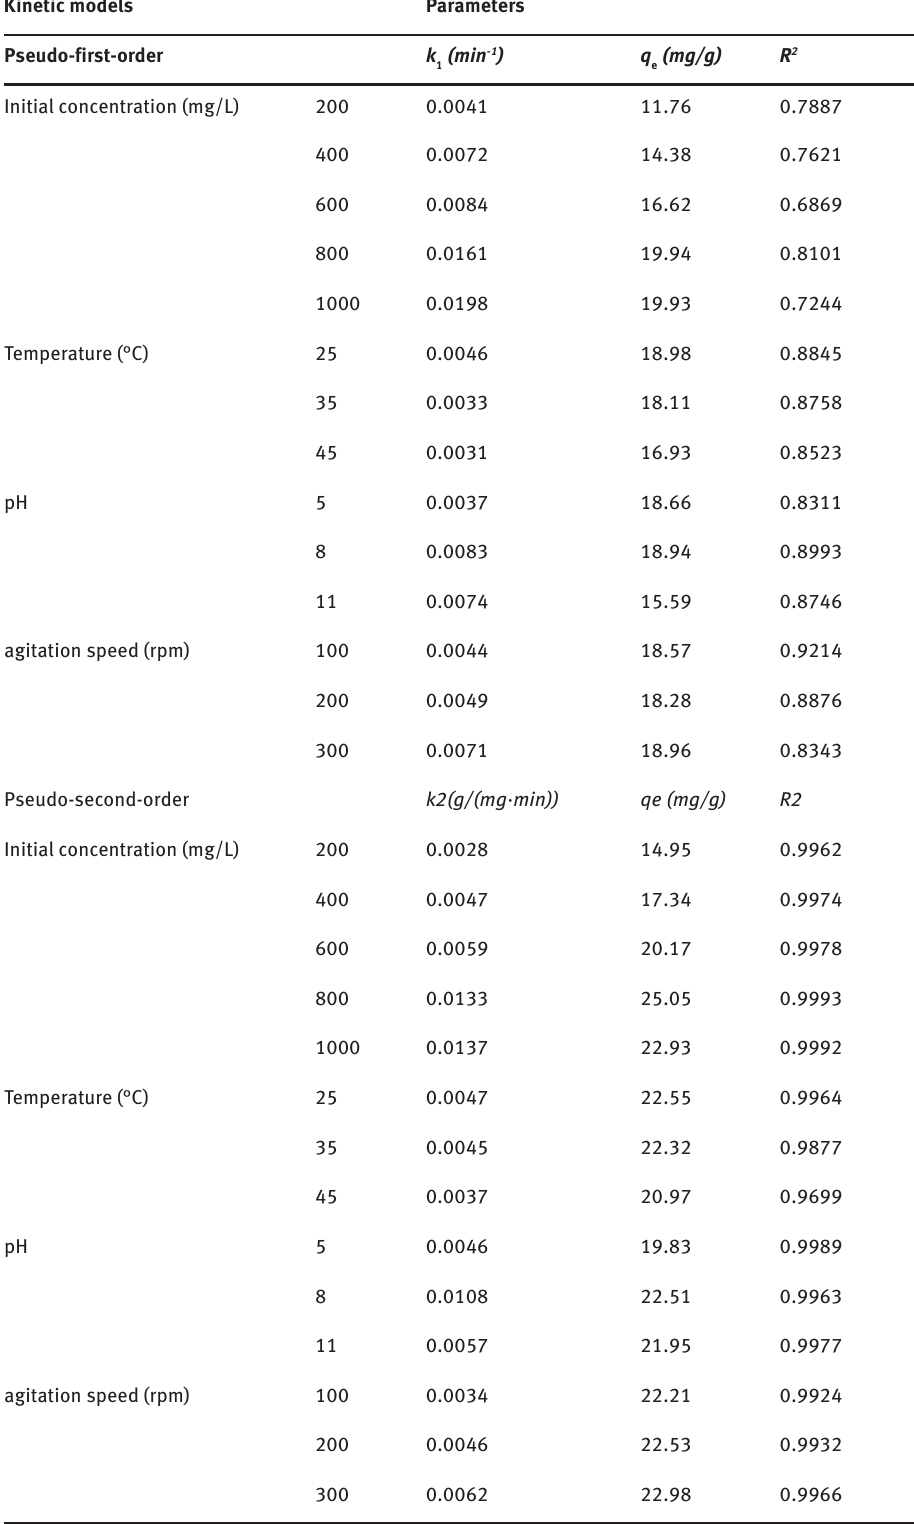
Table 2: Significance of quadratic model coefficient of ammonium adsorbed ( q